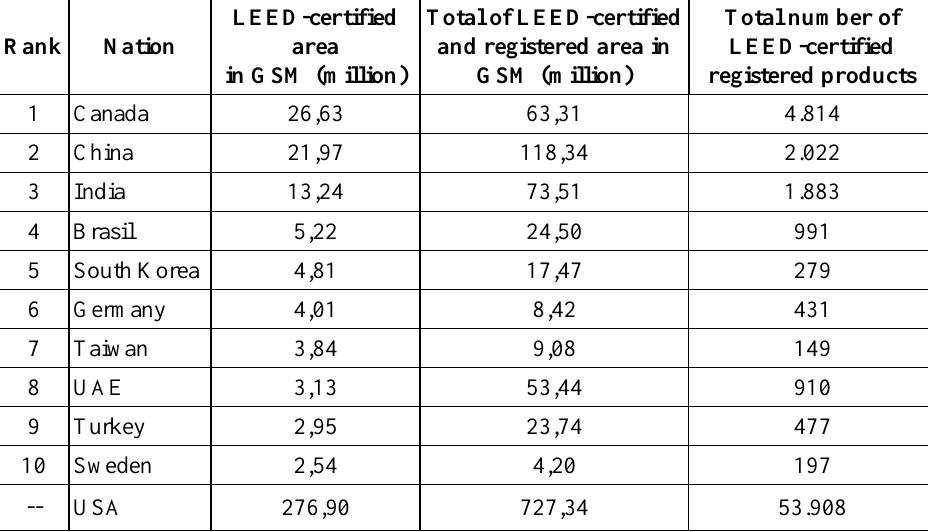
Table 2. Ranking of countries by the amount of LEED certified buildings as of 22.7.2015. (Baulinks,